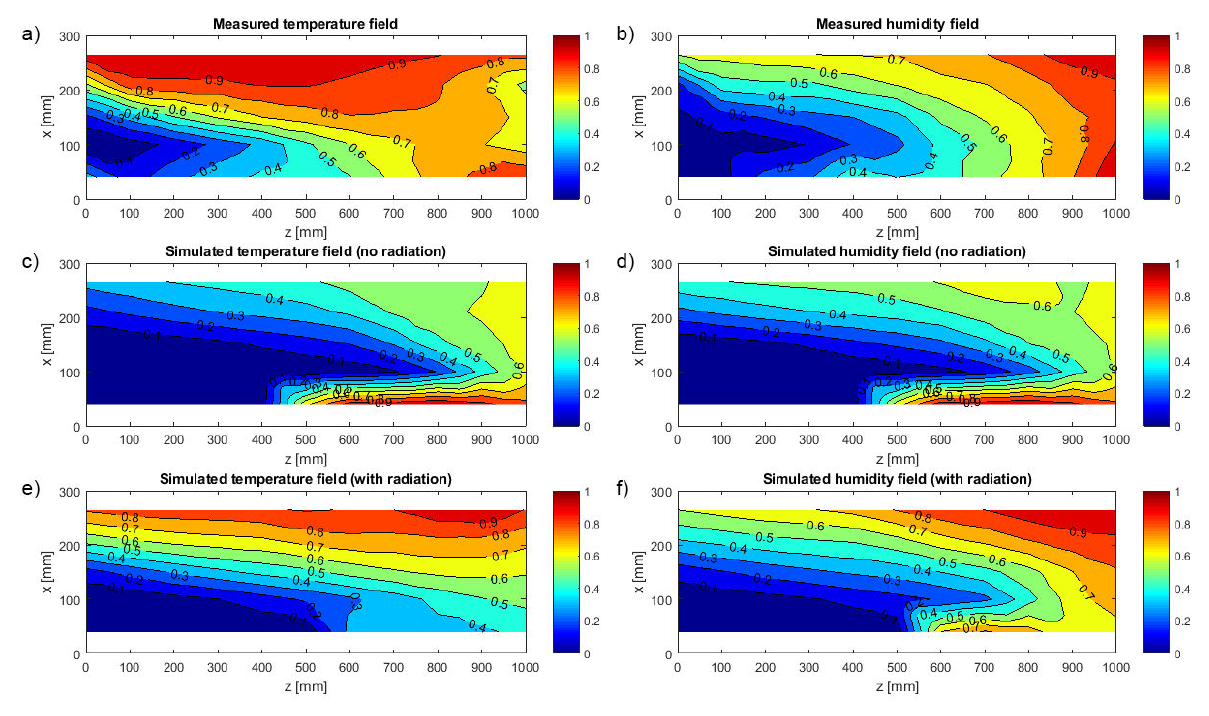
Fig. 5. Case 1 ( ∆ T = 30° C ): Normalized thermal (left) and concentration fields (right) - a,b: experimentally measured; c,d - CFD simulation without radiation; e,f - CFD with radiation (see online version for colors)